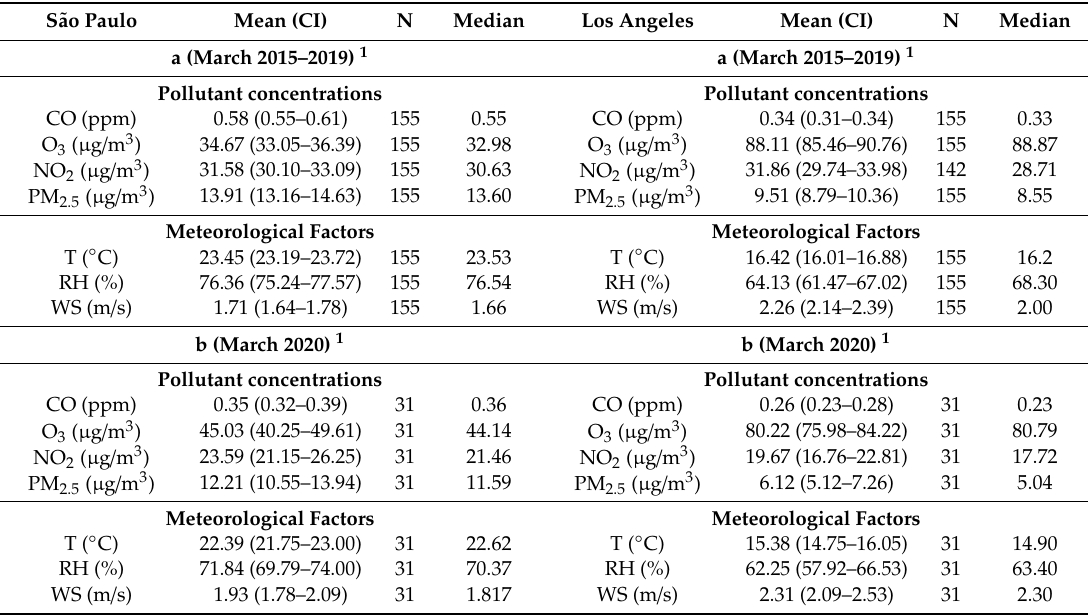
Table 2. ( a ) Descriptive statistics of the dependent and independent variables for S ã o Paulo and